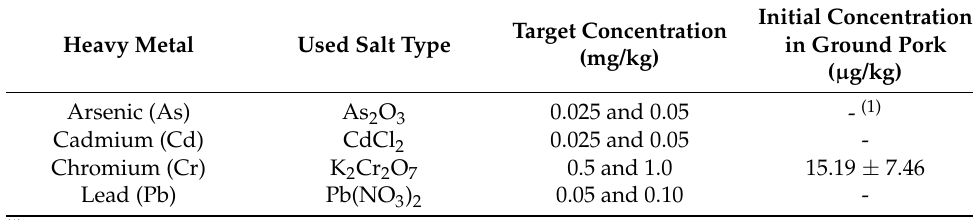
Table 1. Toxic heavy metal salts used and the target concentrations of toxic heavy metals for inten- tional contamination of ground